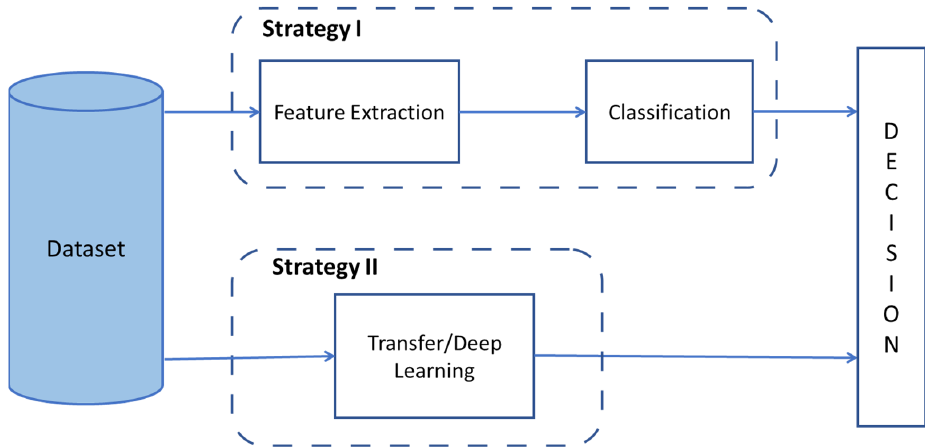
Figure 2. Implemented Strategies for Nosema Recognition.